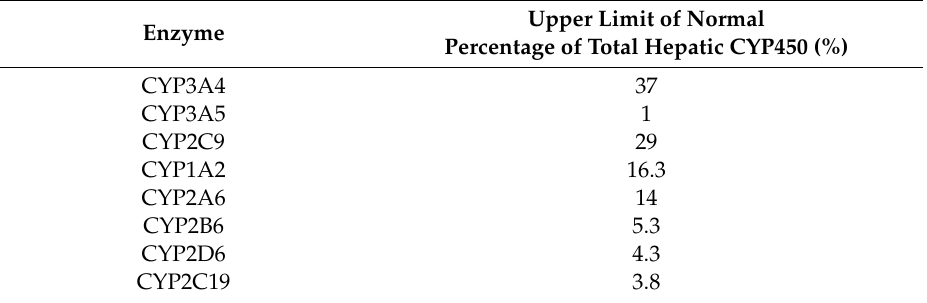
Table 1. Most common cytochrome P450 (CYP450) enzymes in